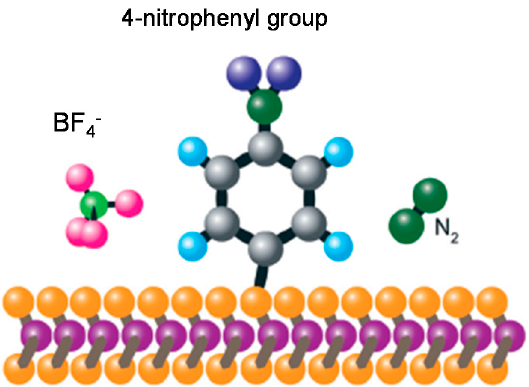
Figure 7. Modification of a MoS 2 sheet by 4-nitrobenzenediazonium (Mo violet, S orange). From Reference [42] with permission of the Royal Society of Chemistry.